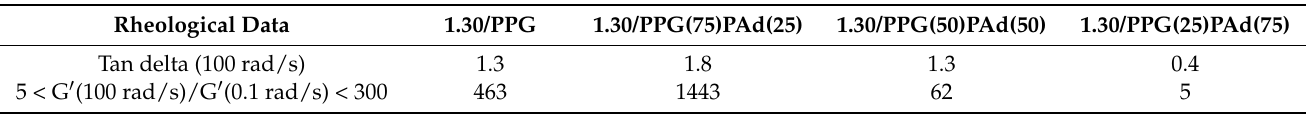
Table 7. Viscoelastic properties of the TPUs related to their PSA characteristics. Frequency sweep plate-plate rheology ex-